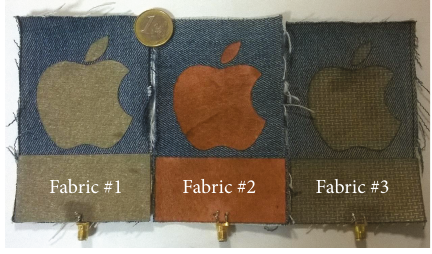
Figure 5: Picture of the fabricated